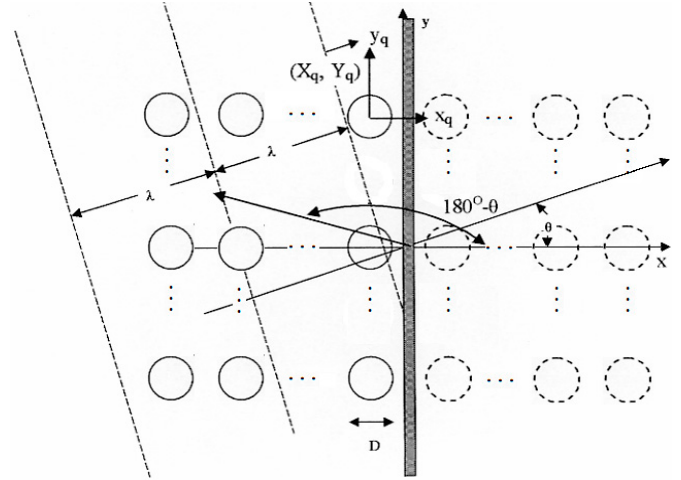
Figure 2. Plan view of the array of N floaters in front of the breakwater (image cylinders are denoted dashed).